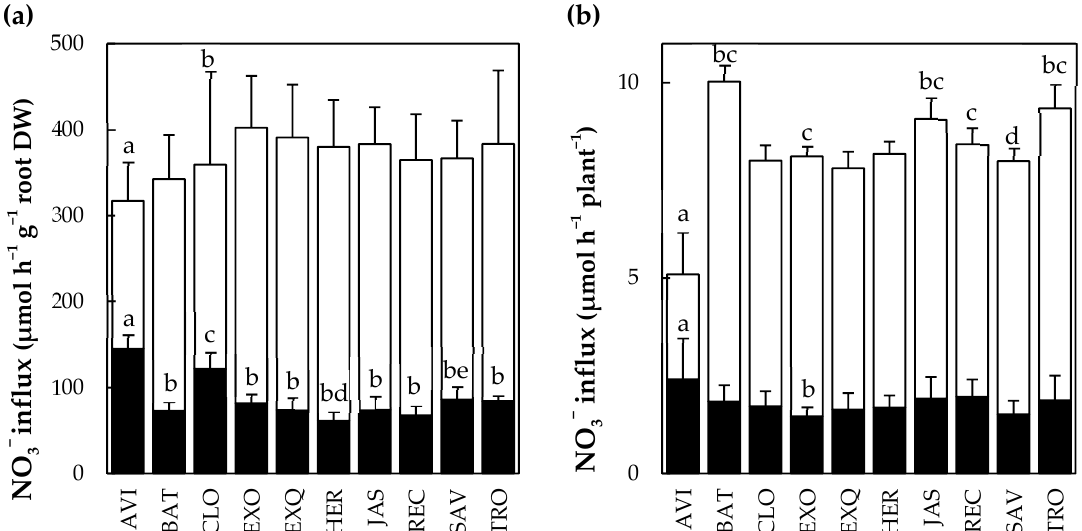
Figure 5. Variability of HATS and combined HATS and LATS activities between oilseed rape cultivars. ( a ) Nitrate influx expressed per hour and per root biomass. ( b ) Nitrate influx expressed per hour and per plant. Black bars: HATS activity, white bars: HATS + LATS activity. N = 6–12 plants ± std. Bars with different letters are significantly different ( p < 0.05) according to Tukey’s HSD test.